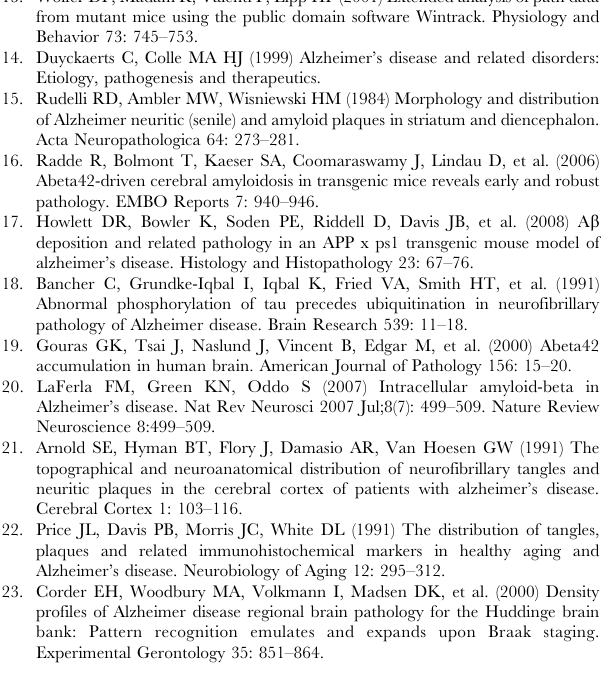
Table S2 Results of behavioural tests examining locomotor and exploratory activity, anxiety and spontaneous alternation of heterozygous and homozygous transgenic mice in comparison to wild type littermates. Data are expressed as means + / 2